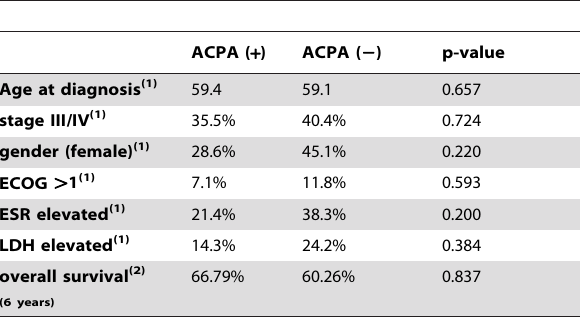
Figure 1 shows the subgroup analysis of the study population (DLBCL patients and healthy controls) stratified into RF IgM- positive versus -negative participants. Statistical evaluation of the RF IgM-positive participants (DLBCL patients and healthy controls) showed a significantly higher frequency of ACPA-positive DLBCL patients than healthy controls (1.77% versus 0%, Table 3. Clinical characteristics of ACPA positive and negative DLBCL